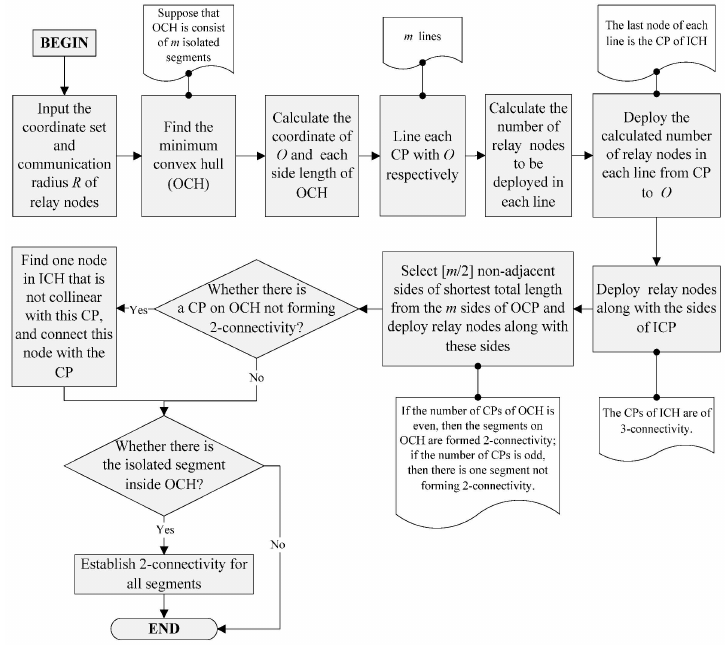
Figure 2. Flow chart of Full 2-Connectivity Restoration Algorithm.